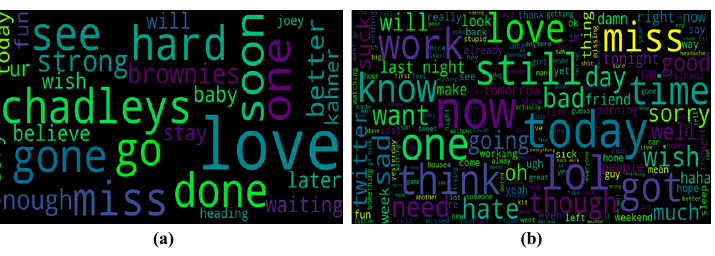
Figure 15. ( a ) Positive and ( b ) negative word dictionary by using the word cloud corpus.